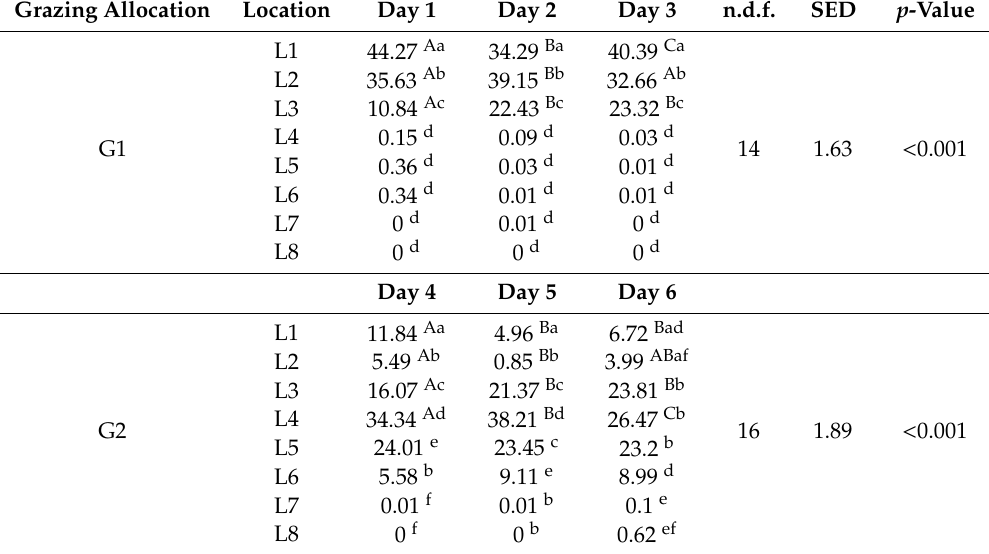
Table 1. Model-predicted means for the proportion of time spent grazing in locations 1 to 8, across three days of grazing within each grazing allocation G1 and G2. Number of degrees of freedom (n.d.f.) and standard error of the di ff erence (SED) are presented. A virtual fence (VF) line was set at the boundary of L3 for G1 and L6 for G2. Means with di ff erent superscripts are significantly di ff erent. ABC indicates significant di ff erence between days, within a location; a–f indicates significant di ff erence between locations, within a